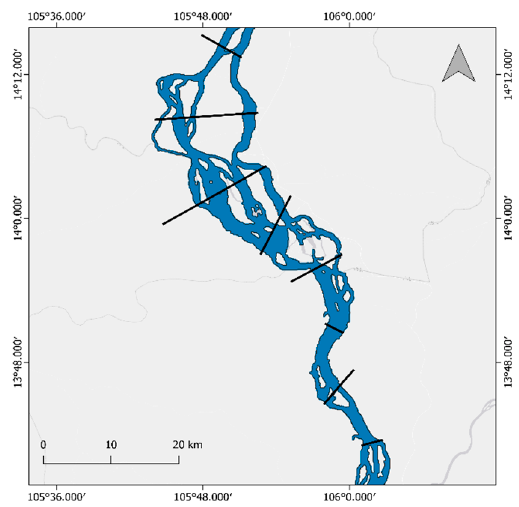
Figure 4. Braided river segment with intersections of different length (black lines).